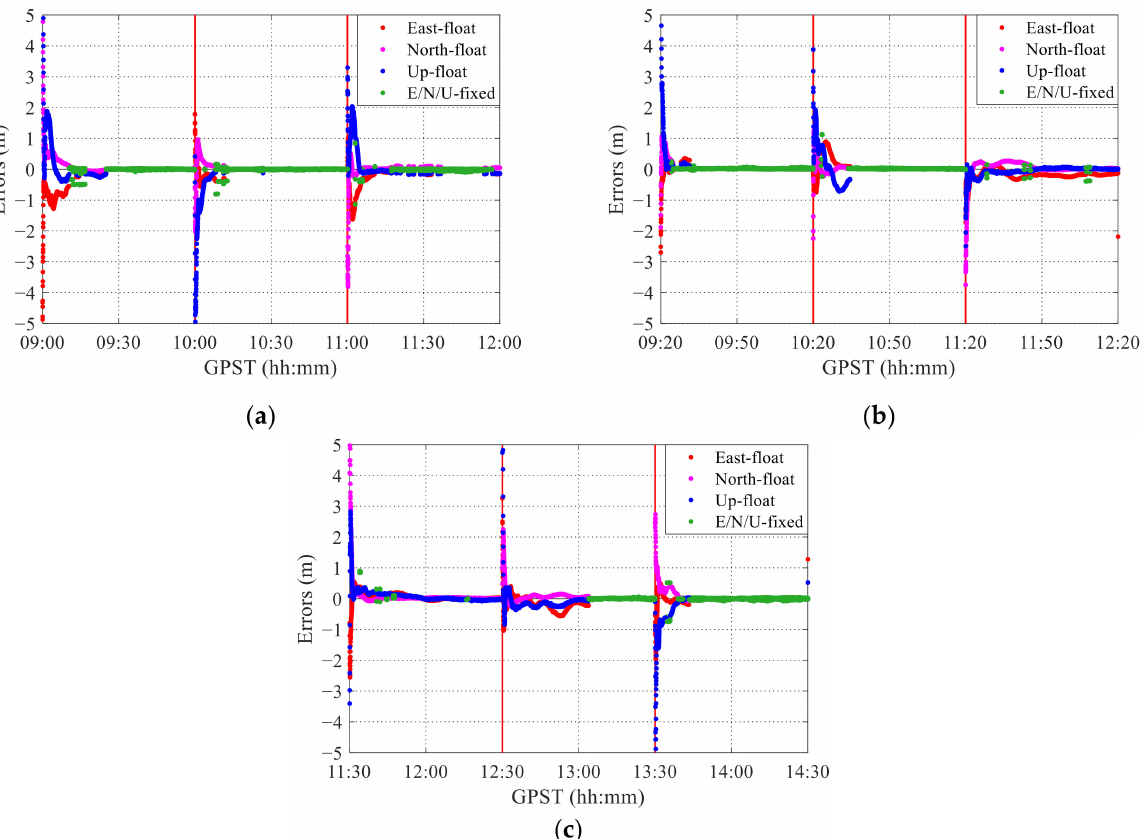
Figure 13. Results of segmented solutions over 1 h intervals for data acquired over 3 days. ( a )